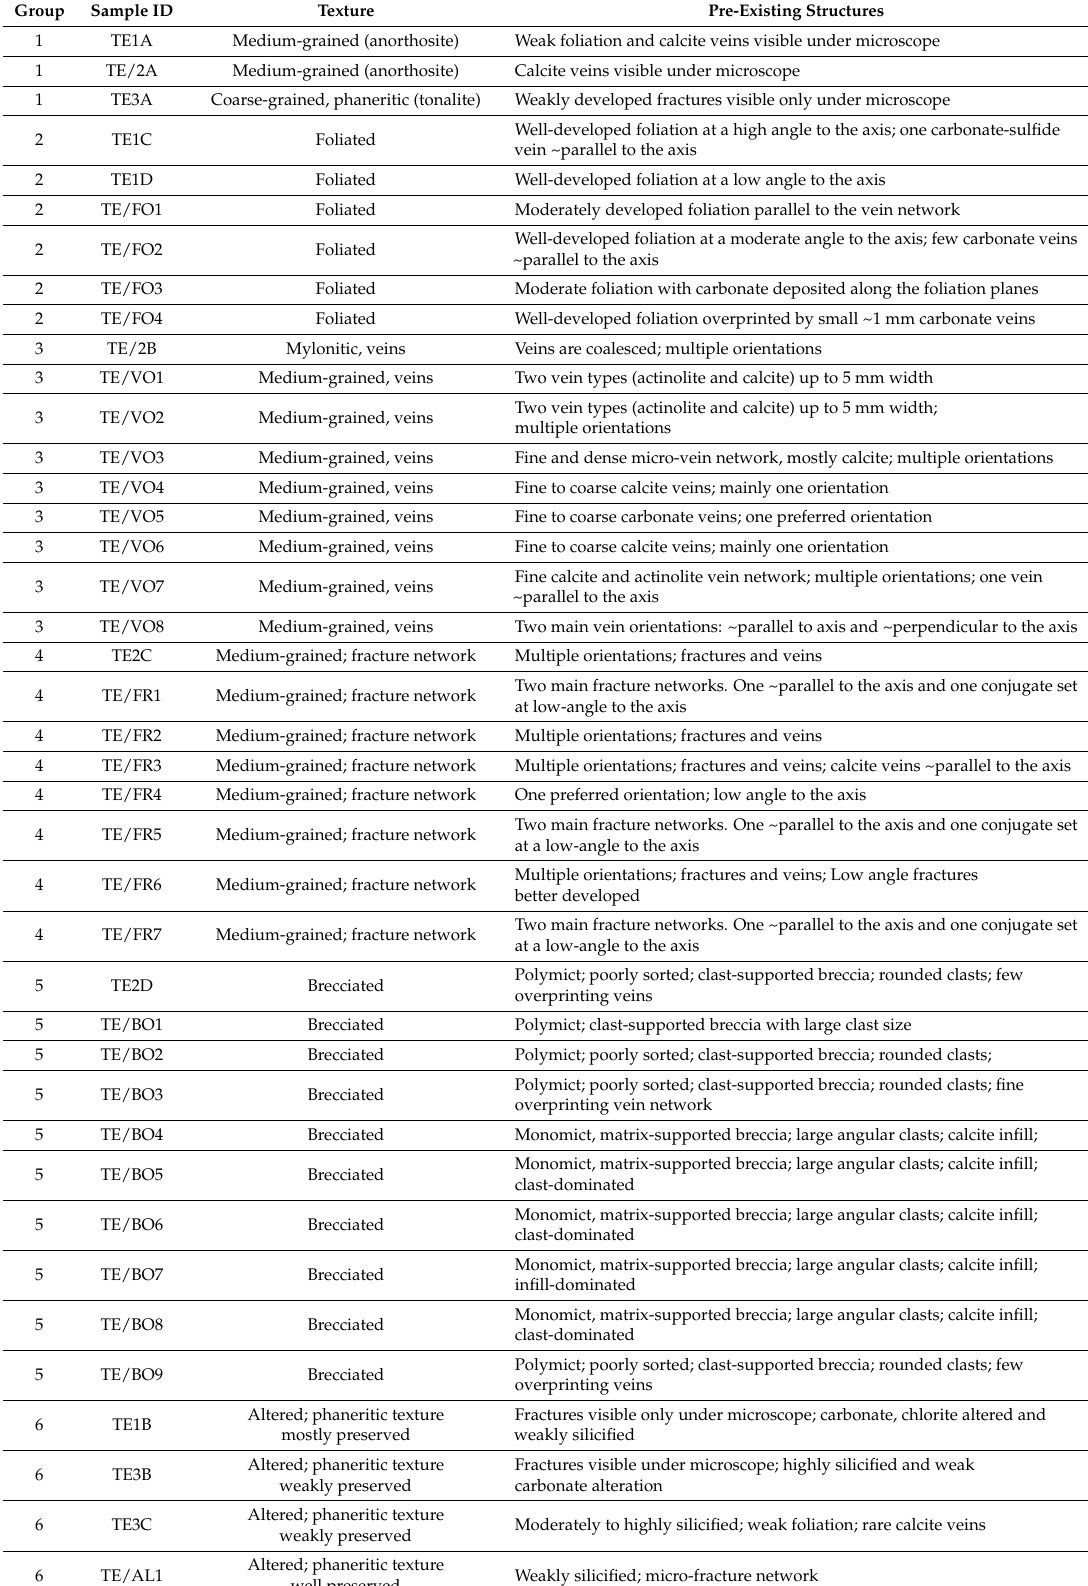
Table 1. Summary table of rock descriptions and rock